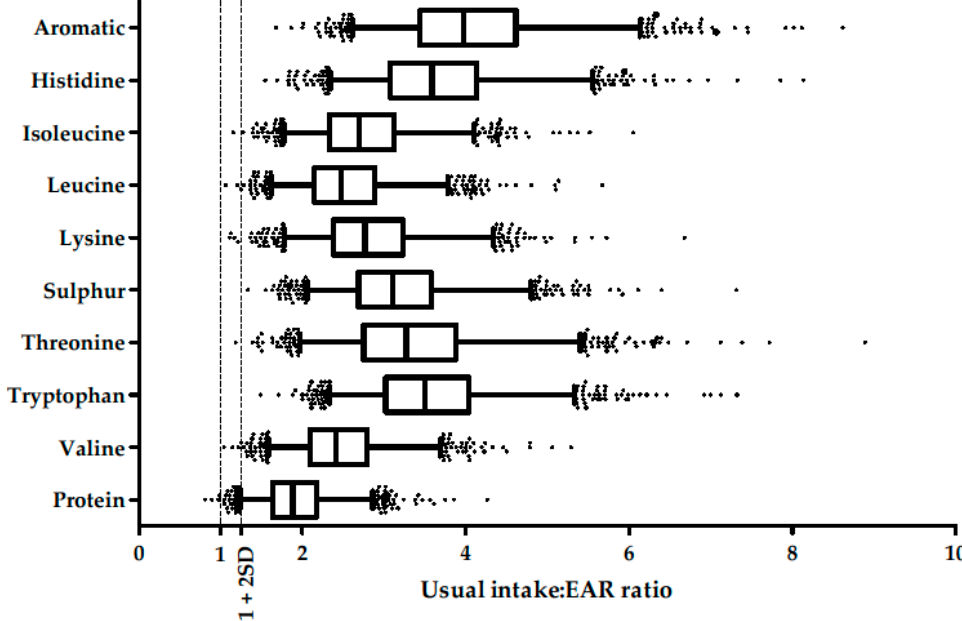
Figure 2. Usual intake:EAR ratio distribution of protein and amino acids in the French adult population (INCA2 study). Distribution of usual intakes of protein and IAA are represented using boxplots with median, 25th and 75th percentiles and whiskers drawn left to the 2.5th and right to the 97.5th percentiles. Points are individuals outside the 2.5th–97.5th percentile range. If the ratio between the usual intake and EAR of an individual was equal to 1, the probability of an adequate intake was 50% and if the ratio was 1 + 2SD, the probability of an adequate intake was 97.5%. The prevalence of inadequacy in the population was lower than 0.05% for all IAA and 0.31% for protein. EAR, Estimated average requirement; INCA2, Individual and National Consumption Survey 2 ( n = 1678).